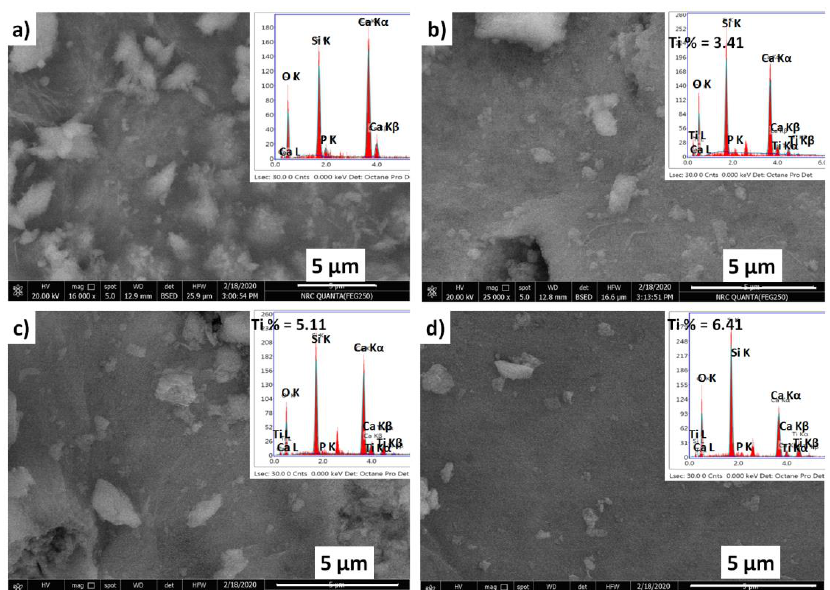
Figure 5. Scanning electron micrographs and corresponding energy-dispersive X-ray spectroscopy spectra of TiO 2 -doped glasses with reference to the native glass; ( a ) BGT0, ( b ) BGT5, ( c ) BGT7.5 and ( d ) BGT10.